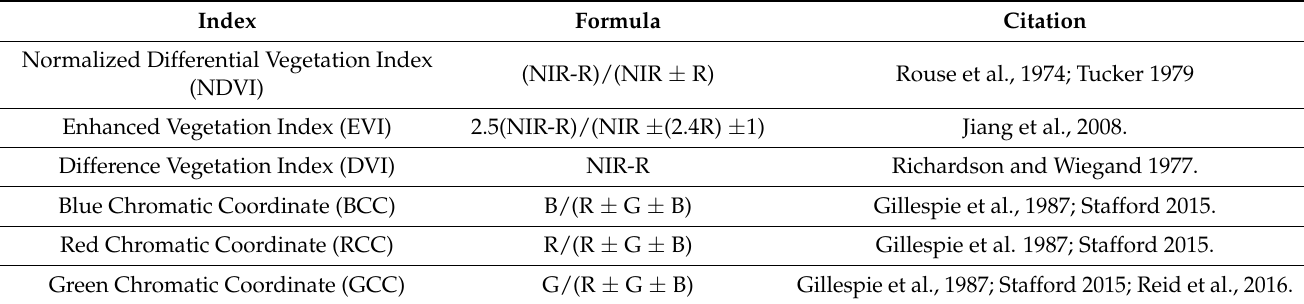
Table 3. Spectral indices calculated from the four-band imagery and used in the vigor model and classification of Ponderosa pine individual tree crowns (ITCs). NIR = near-infrared band, R = red band, B = blue band, G = green band. Index Formula Citation Normalized Differential Vegetation Index (NIR-R)/(NIR ± R) Rouse et al., 1974; Tucker 1979 (NDVI) Enhanced Vegetation Index (EVI) 2.5(NIR-R)/(NIR ± (2.4R) ± 1) Jiang et al., 2008. Difference Vegetation Index (DVI) NIR-R Richardson and Wiegand 1977. Blue Chromatic Coordinate (BCC) B/(R ± G ± B) Gillespie et al., 1987; Stafford 2015. Red Chromatic Coordinate (RCC) R/(R ± G ± B) Green Chromatic Coordinate